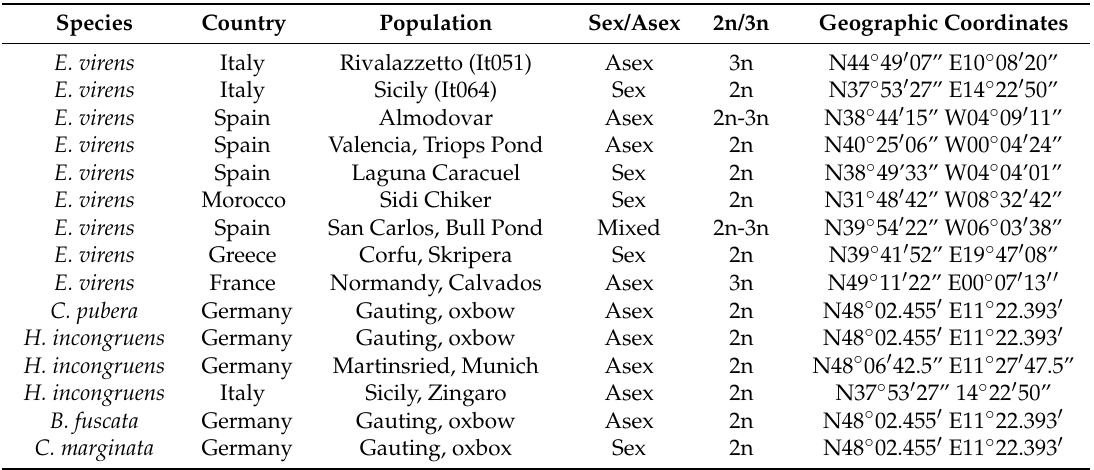
Table 1. Overview of population of Eucypris virens and other ostracod species analysed.